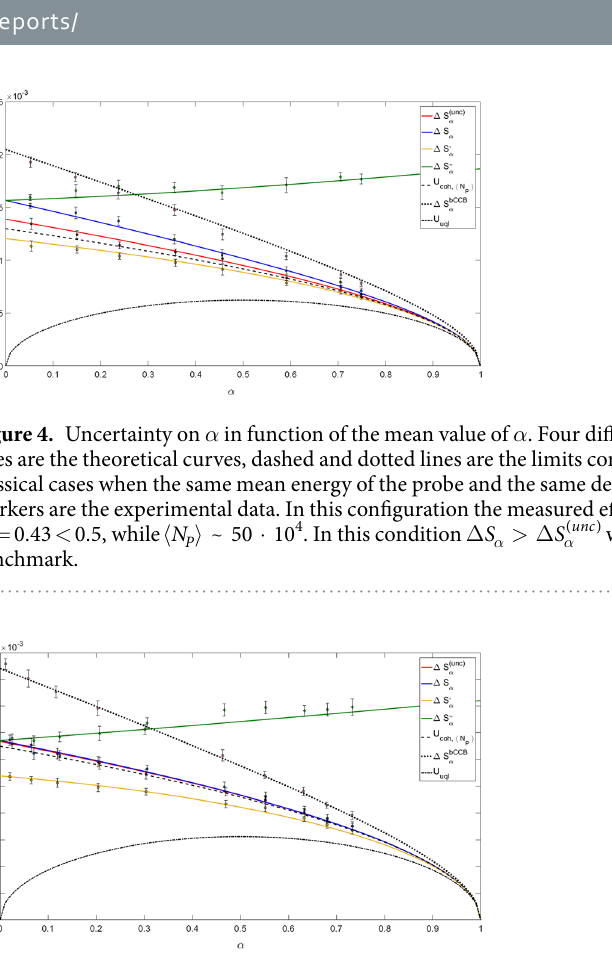
Figure 5. Uncertainty on α in function of the mean value of α . Four different estimators are considered. Solid lines are the theoretical curves, dashed and dotted lines are the limits corresponding to the best quantum and classical cases when the same mean energy of the probe and the same detection efficiency are considered.The markers are the experimental data. In this configuration the measured efficiencies are η P = 0.76 and η R = 0.49, 4 while 〈 〉 ⋅ ~ N 50 10 P